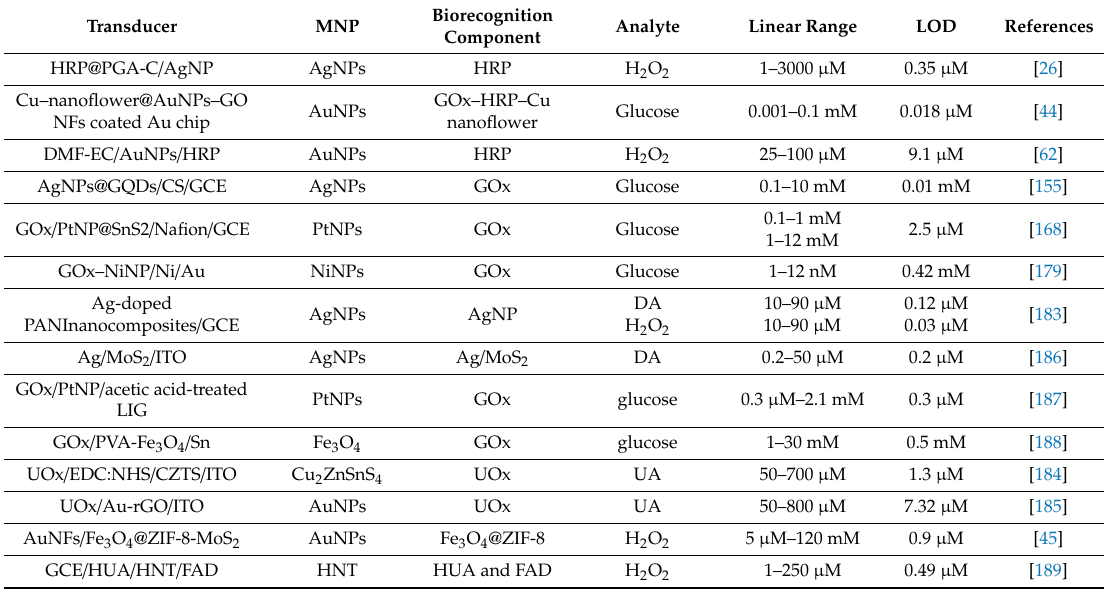
Table 2. A brief description of various ECBs that have been reported from detection of glucose, dopamine (DA), H 2 O 2 , and uric acid (UA).